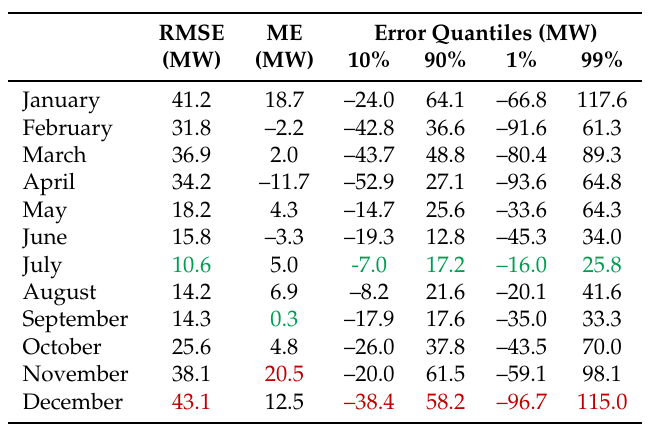
Table 2. Summary of the hourly forecast error for each month for the SVR model using real weather forecasts, calendar, and holiday data. Histograms of the forecast error appear in Figure 6. The months with the worst performance are indicated in red, the best in green. The quantiles are evaluated in pairs, so the widest symmetric quantile interval is considered the